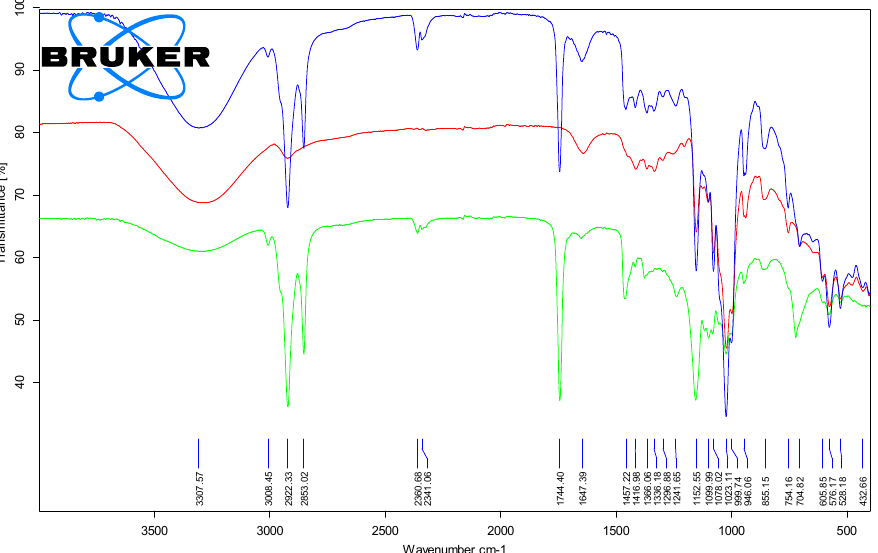
Figure 6. Superimposed ATR-FTIR spectra for the β -cyclodextrin/processed chicken breast lipid complex (top—blue), β -cyclodextrin (middle—red) and lipid fraction from the processed chicken breast (bottom—green) (duplicate samples “a”).